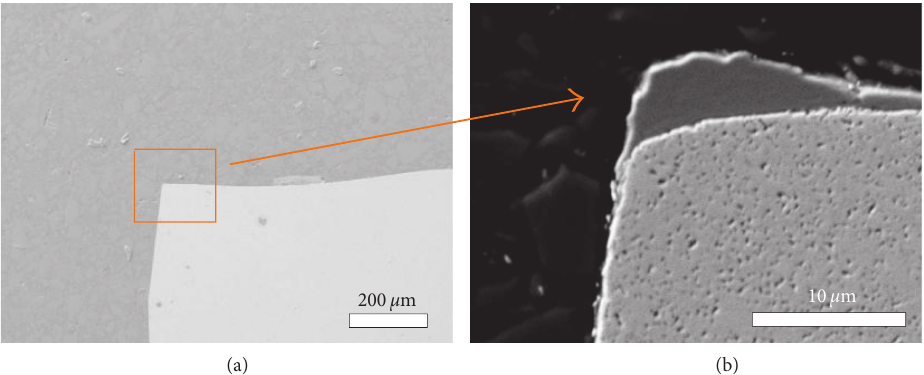
Figure 9: SEM picture of worn uncoated cutting tool in final state (after cutting length of 7084m) with cutting parameters as follows: 𝑓 = 0.30 mm/rev, and 𝑎 = 0.1 mm. Due to the high temperatures acting in the cutting zone some evidence is seen for 𝑣 𝑐 = 100m/min, 𝑝 plastic lowering of the cutting edge [9].